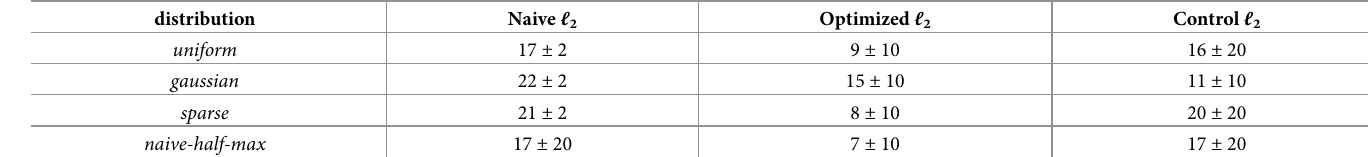
Table 5. ISI goodness of fit measured with ℓ 2 distance between histograms. Actual values are 100 times those reported above. distribution